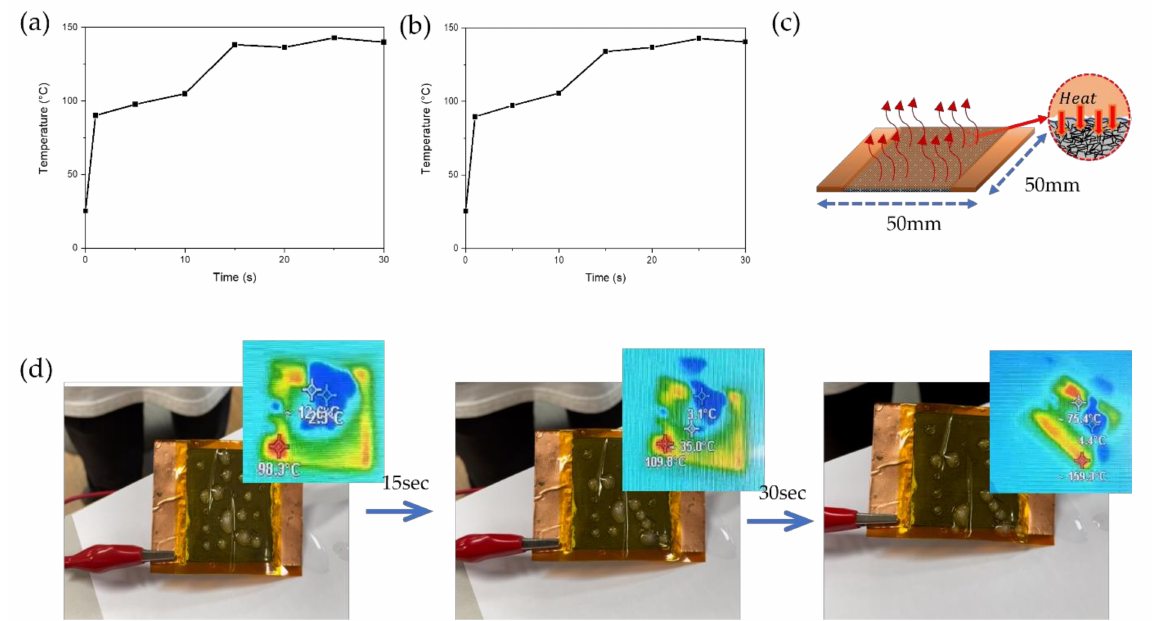
Figure 8. Joule heating (12 V) by attaching Kapton tape on LIG heater (50 mm × 50 mm): ( a ) de-icing test (1.5 mL) with Kapton/LIG heater, ( b ) de-icing test (1.5 mL) with Kapton/aluminum foil/LIG heater. ( c ) Schematic of LIG heater for heat accumulation in pore structure and roughness pattern. ( d ) De-icing test of water droplet (3 mL) with Kapton tape/LIG